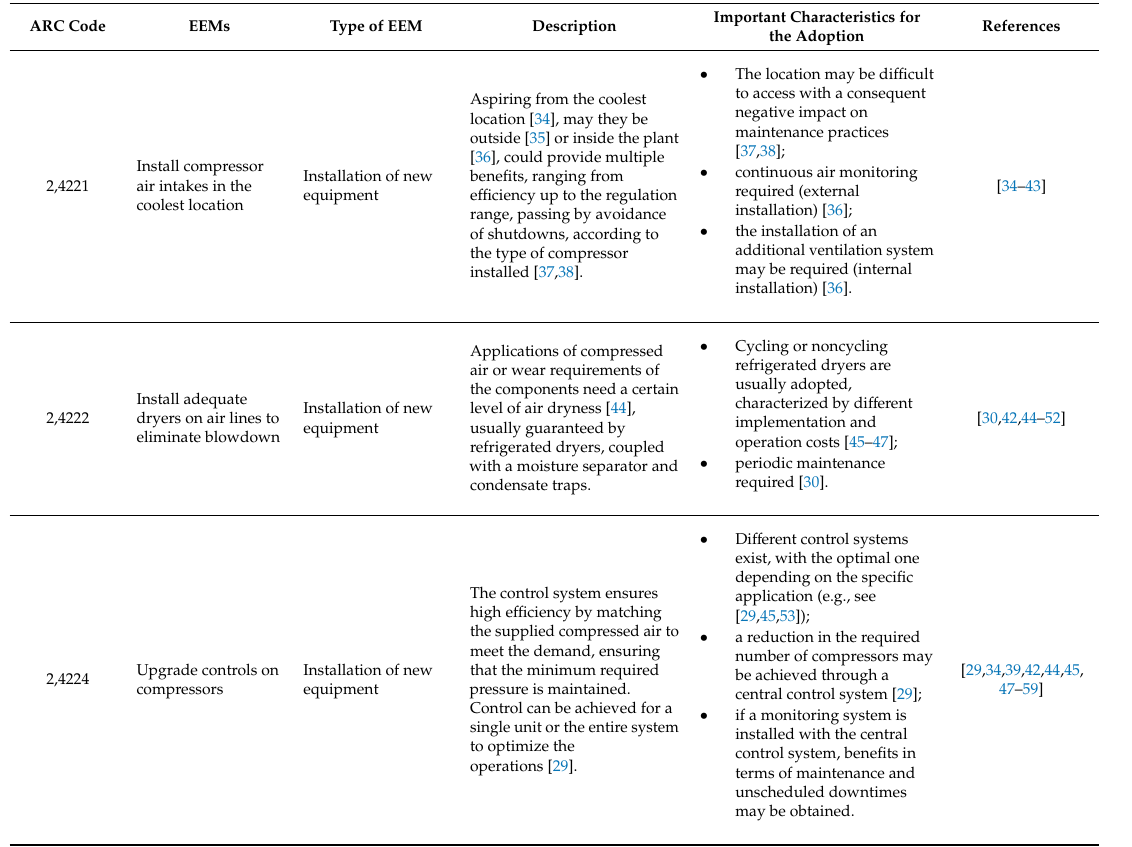
Table 1. Industrial Assessment Center (IAC) classification of EEMs in